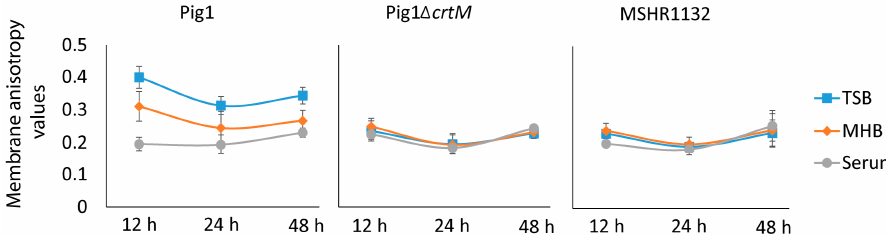
Figure 2. Staphyloxanthin in the pigmented S. aureus helps cells maintain membrane fluidity over stationary phase too. Membrane anisotropy values of the stationary phase cells were determined using a membrane intercalating fluorescent dye (DPH) as described for the log phase cells. Note that anisotropy values do not have unit. Error bars indicate standard deviation from mean anisotropy values obtained from at least three independent experiments.